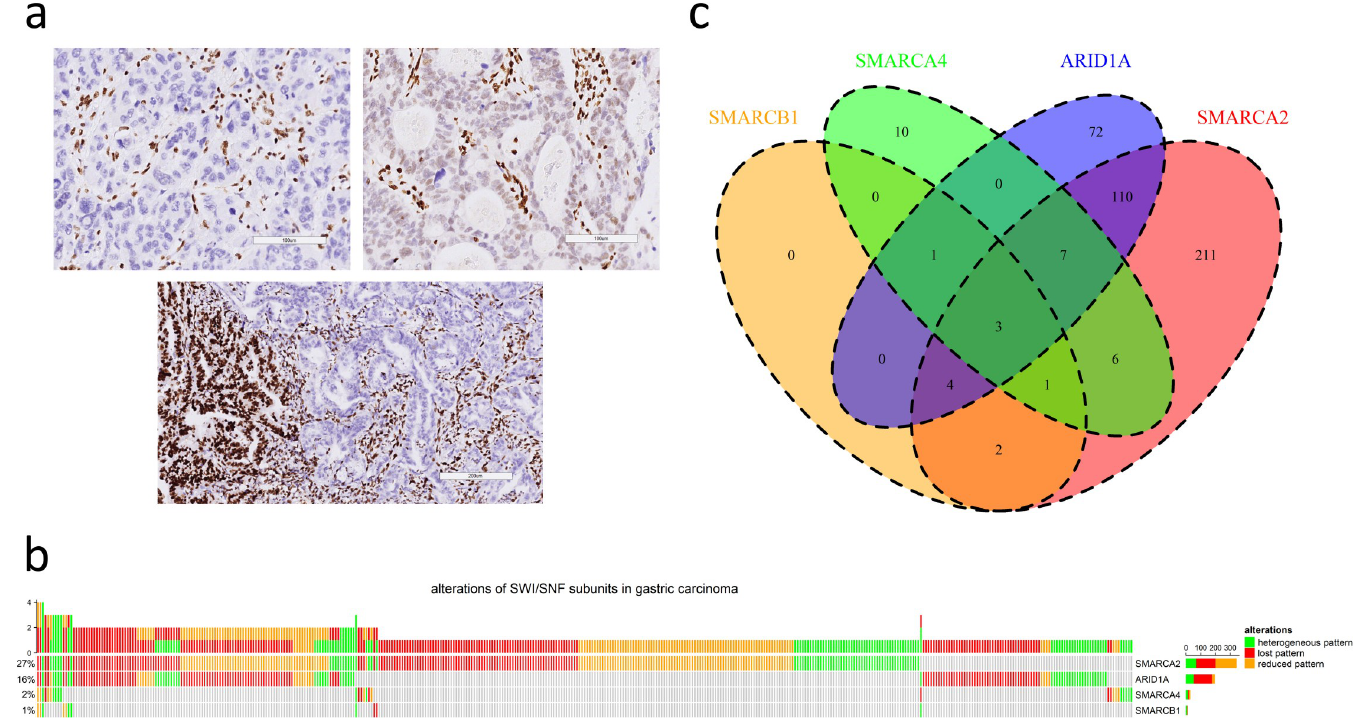
Fig 1. a. Three immunohistochemical patterns of attenuated SWI/SNF subunits in gastric cancers (upper left: lost pattern, upper right: reduced pattern, lower: heterogeneous pattern; scale bar in upper left and upper right: 100 μ m, scale bar in lower: 200 μ m). b. The oncoprint plot summarizes the distribution of attenuated SWI/ SNF subunits, including SMARCA2, ARID1A, SMARCA4 and SMARCB1. c. The Venn diagram demonstrates synchronous alterations in multiple SWI/SNF subunits.